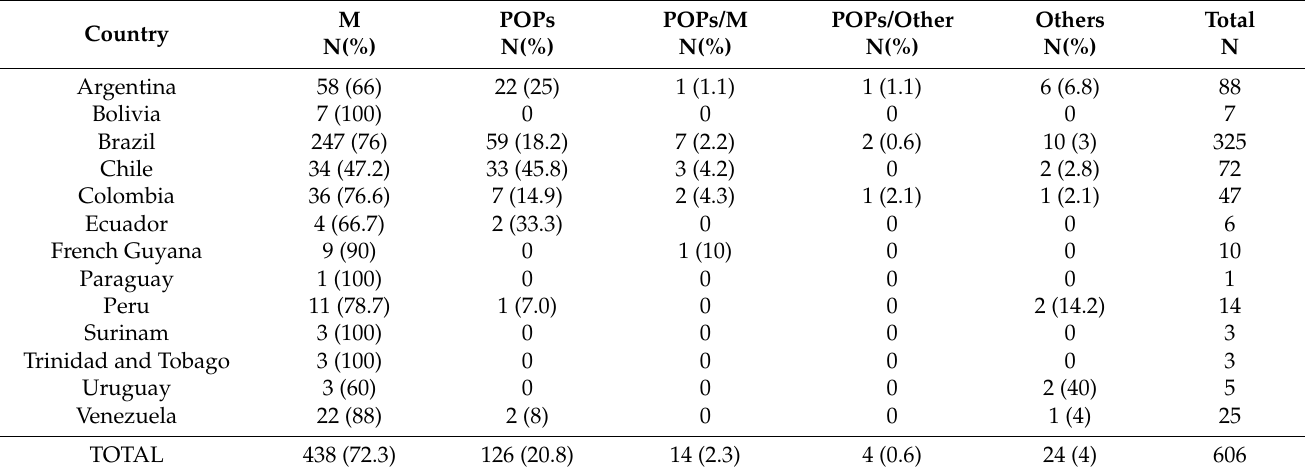
Table 1. Number of publications by country of concentrations of trace metals (TM), persistent organic compounds (POPs) and others. N (%): numbers express the total publications and in parentheses the percentage with respect to the